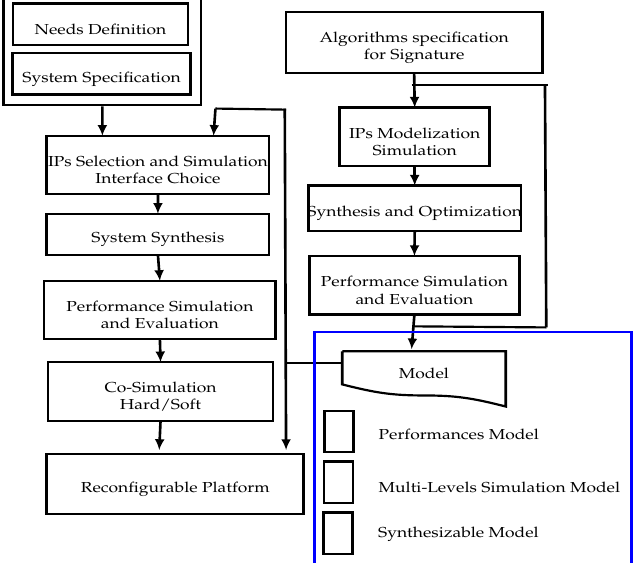
Figure 1. The proposed methodology and flow design of the Elliptic Curve Digital Signature Algorithm